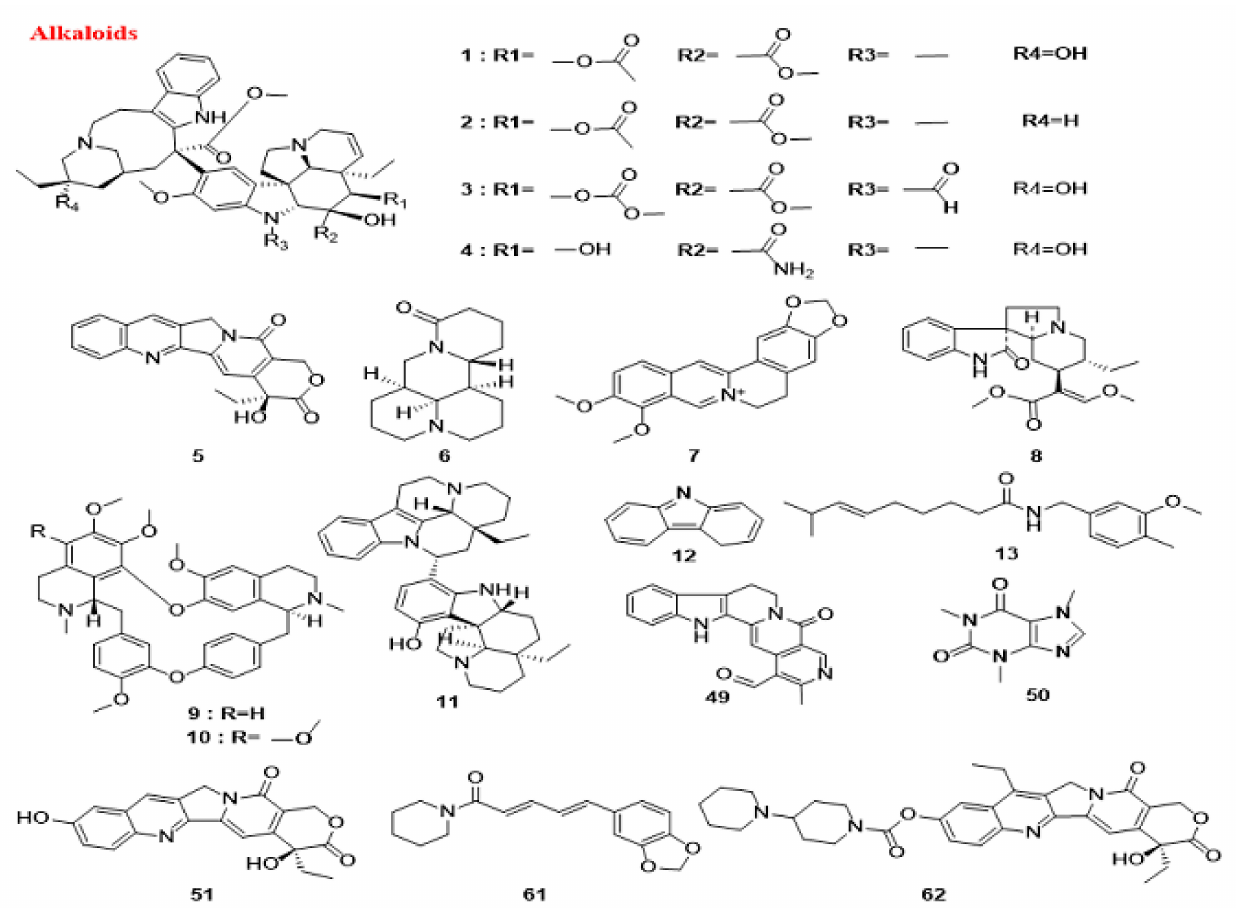
Figure 6. Chemical structures of alkaloids. Vinblastine (1), vinorelbine (2), vincristine (3), vindesine (4), camptothecin (5), matrine (6), berberine (7), isorhynchophylline (8), tetrandrine (9), hernandezine (10), bisleuconothine A (11), carbazole (12), capsaicin (13), subditine (49), caffeine (50), hydroxycamptothecin (51), piperine (61), irinotecan (62). The images were prepared using ChemDraw Professional